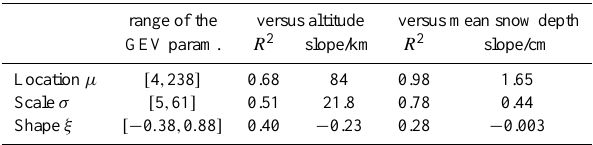
Table 1. Summary of linear dependence of the GEV parameters of Sect. 4 with altitude (columns 3 and 4) and with the mean snow depth (columns 5 and 6). In all cases, covariates are very signifi- cant (p-values lower than 10 − 6 ). Altitude ranges between 230 and 2540m, mean snow depth between 0.5 and 146cm. The range of the N = 84 estimated GEV parameters is indicated in the first col- umn. range of the versus altitude versus mean snow depth GEV param. R 2 slope/km R 2 slope/cm Location µ [ 4 , 238 ] 0.68 84 0.98 1.65 Scale σ [ 5 , 61 ] 0.51 21.8 0.78 0.44 Shape ξ [− 0 . 38 , 0 . 88 ] 0.40 − 0.23 0.28 −